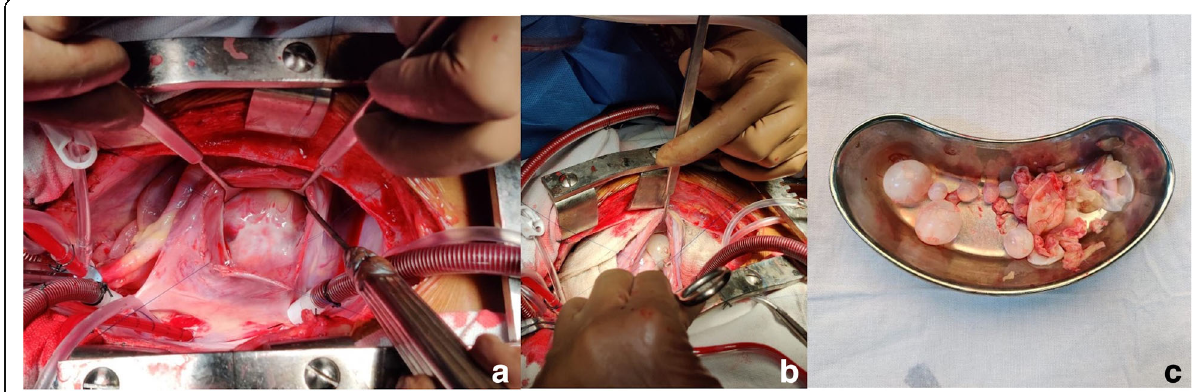
Fig. 3 Surgical field images showing a Large hydatid cyst over the interventricular septum with intact wall. b Cyst wall was excised and daughter cysts inside the cavity can be seen. c Daughter cysts removed outside the